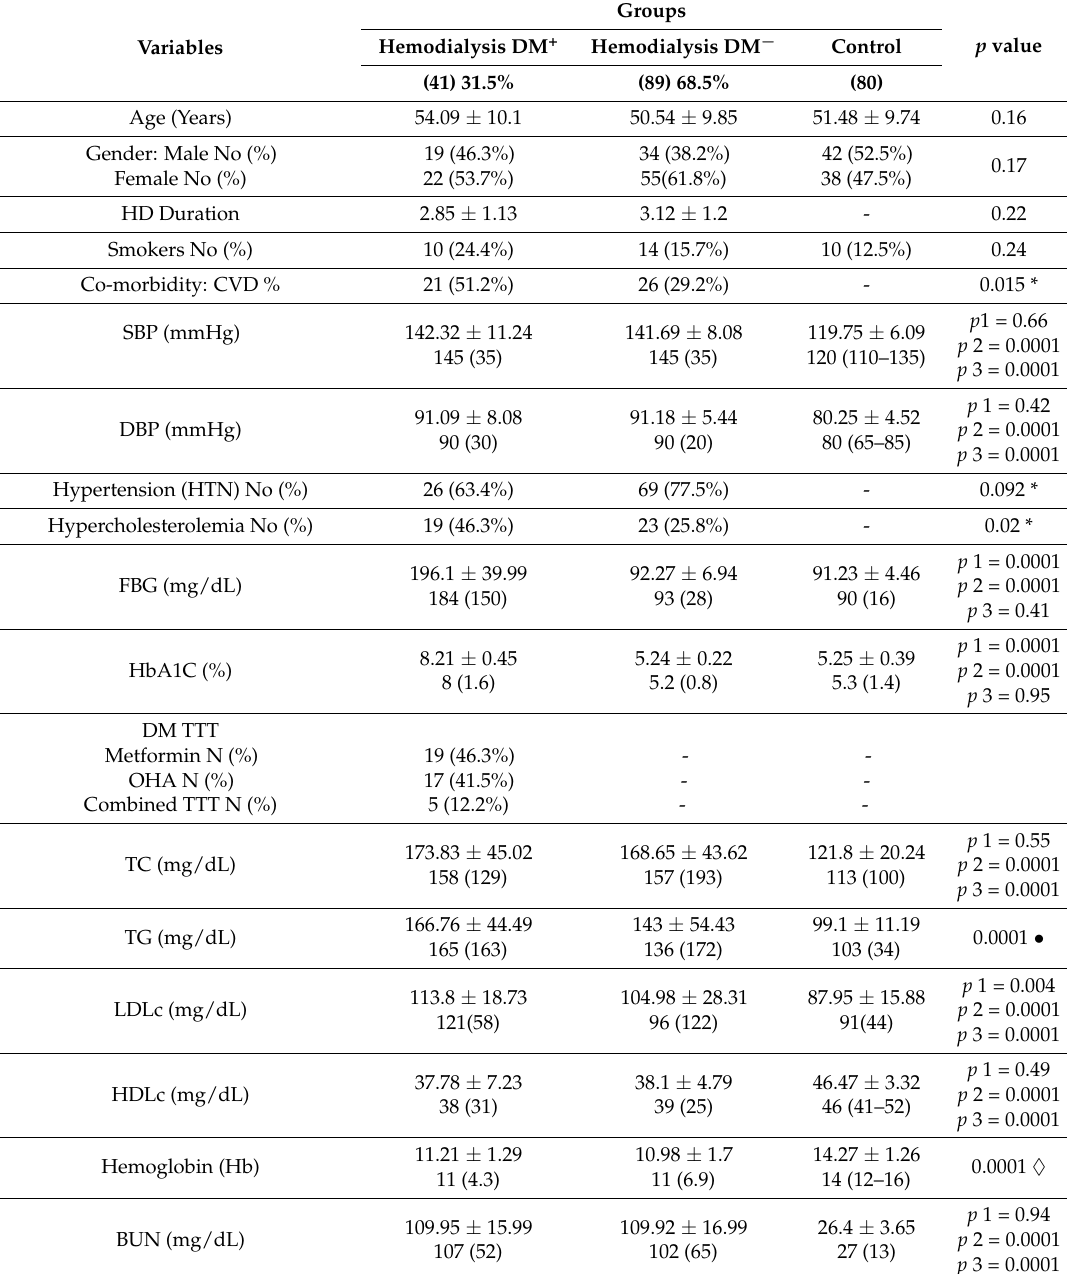
Table 1. Demographic, clinical, and biochemical data between the studied